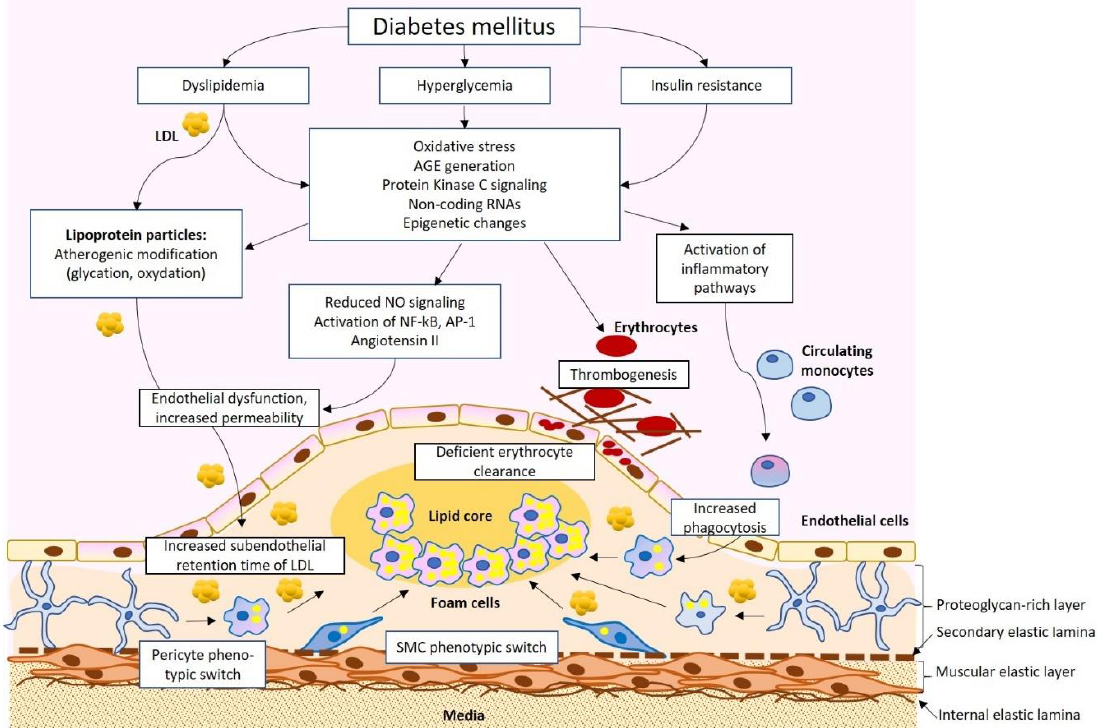
Figure 1. A simplified scheme of the pathophysiological connection of diabetes mellitus and atherosclerosis. Dyslipidemia, hyperglycemia, and insulin resistance result in a spectrum of physiological changes, including the formation of atherogenic low-density lipoprotein (LDL), advanced glycation end products (AGE), and activation of pro-inflammatory signaling that impact different cell types of the arterial wall, resulting in atherosclerotic lesion development. SMC, smooth muscular cells.